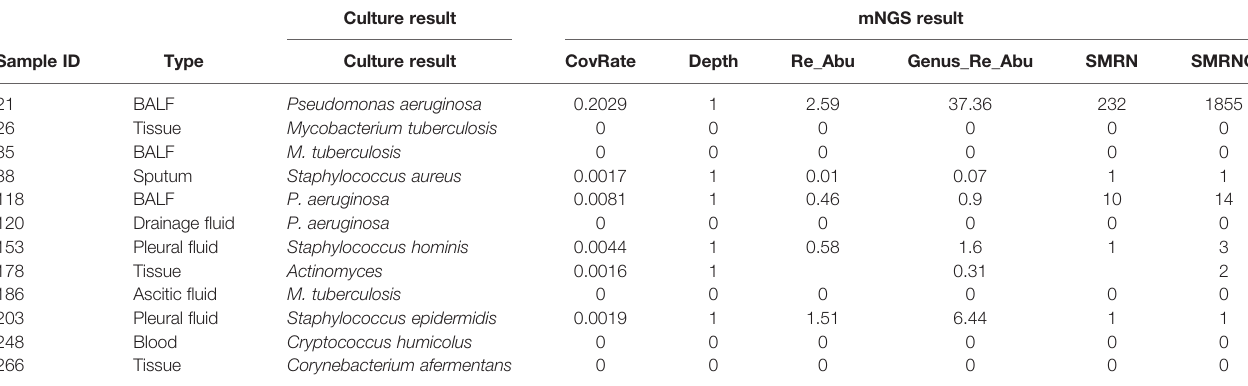
TABLE 4 | List of 12 paired-culture positive cases.